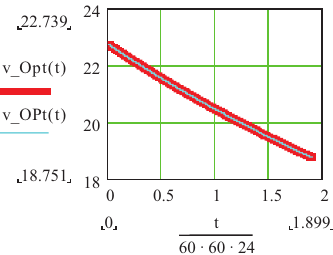
Figure 4. Optimal speed as a function of time for the corresponding variable mass of the flying object In Figure 4, the curve of v_Opt(t) (bold red line) is plotted by the formula with the mass depending upon time and v_OPt(t) (light blue line) by the formula derived based upon the v_Opt(t) expression. Both curves coincide.